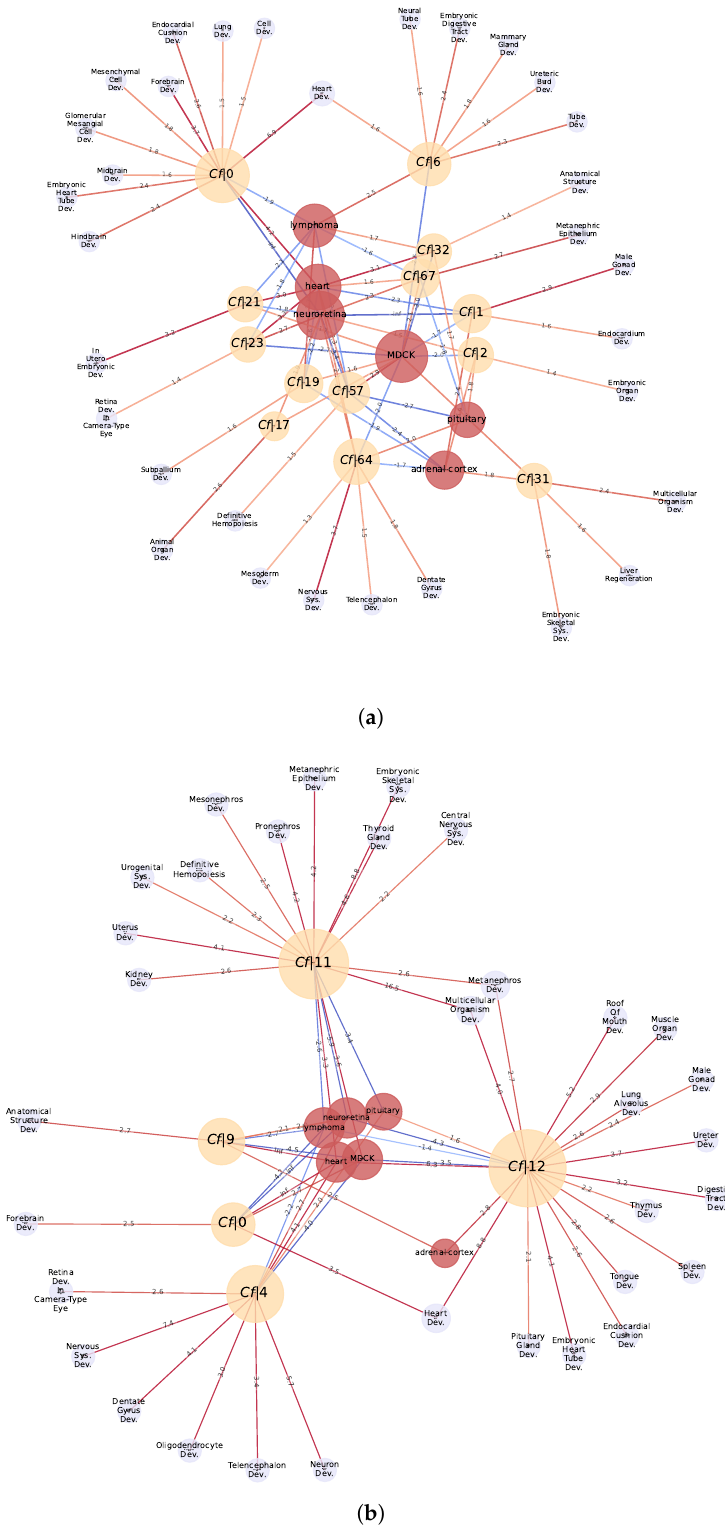
Figure 7. Statistically significant Normalized Enrichment GSEA Scores between cell-types (red nodes) and GXN•OMP and GXN•EN GRN communities (yellow nodes), and statistically significant associations between GO terms (blue nodes) and GXN•OMP and GXN•EN communities, for the C. familiaris dataset; ( a ) GXN•OMP- C. familiaris ; ( b ) GXN•EN- C. familiaris